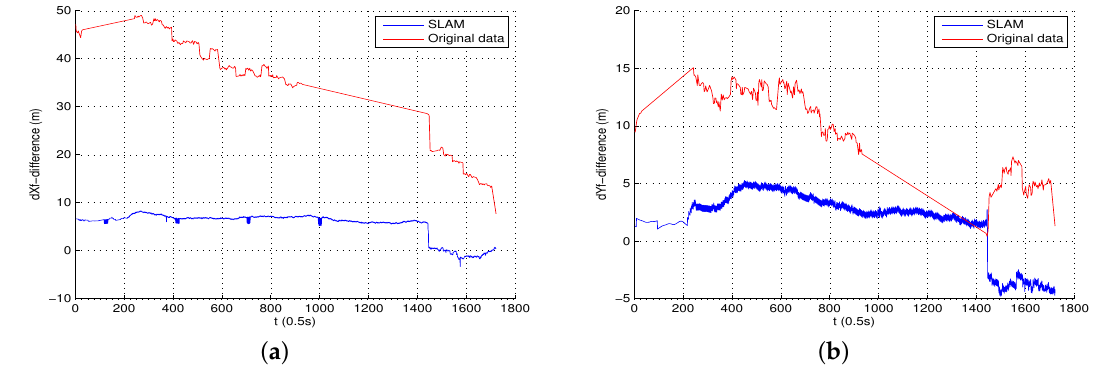
Figure 21. Deviation between estimated position and true position of M-DS recorded by IMU in AUV homing to the M-DS are illustrated by that in ( a ) X direction and ( b ) Y direction. In Figure 22, the blue line and red line respectively show the deviation between the estimated position and the true position of AUV sensed by IMU with the the maximum working range corresponding to measurement error data less than 150 m and less than 250 m. In the Figure 23, the blue line and red line respectively show the the deviation between the estimated position and true position of M-DS sensed by IMU with the maximum working range corresponding to the measurement error data less than 150 m and less than 250 m. The black line shows the position of M-DS directly estimated by the measurement of the sensor. We can know that the positioning accuracy of the SLAM algorithm with the maximum working range corresponding to measurement error data less than 150 m is lower than that with the maximum working range corresponding to measurement error data less than 250 m, but higher than that of the original algorithm. So even if the initial distance between AUV and DS exceeds the maximum working distance corresponding to the measurement error data, the algorithm proposed in this paper is still effective.